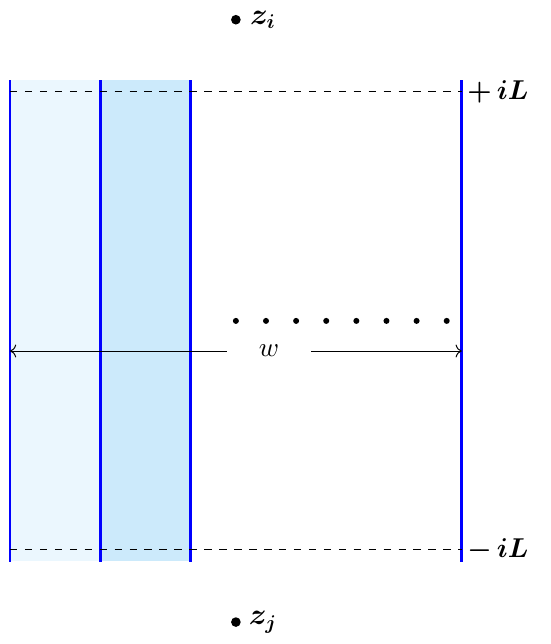
Figure 2 . A vertical strip of width w in the u -plane. Regulators at u = ± iL are